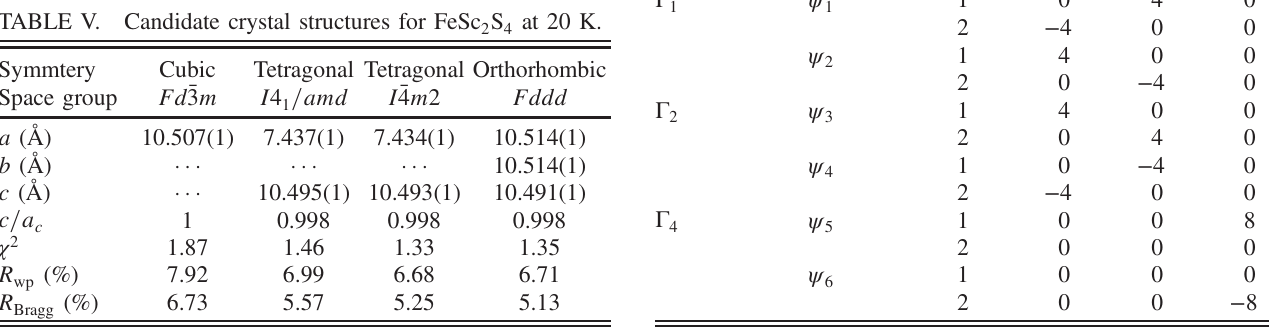
TABLE VI. Basis vectors for the space group Fd k ¼ ð 001 Þ .